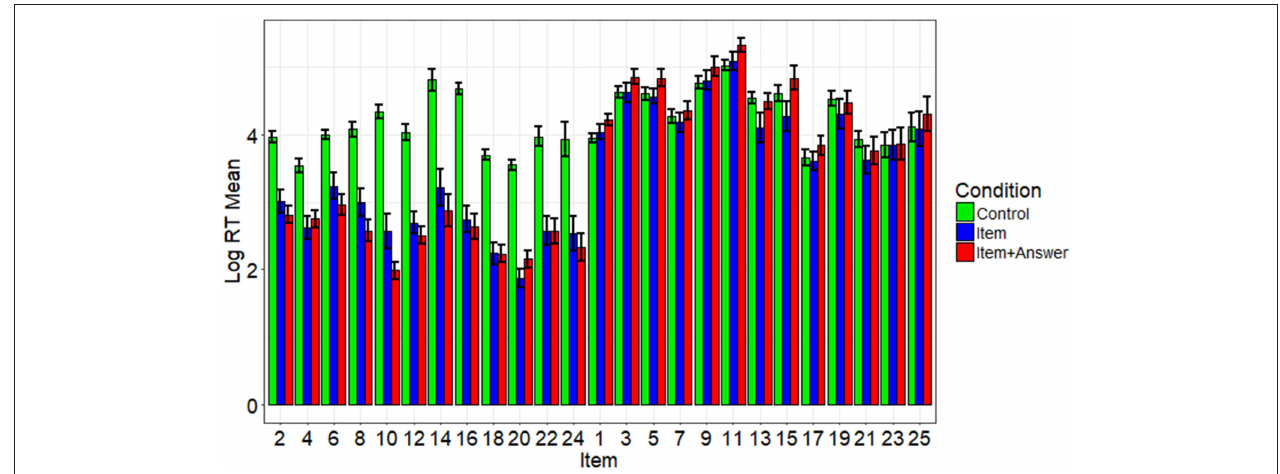
FIGURE 1 | Average log RTs by item and condition. This figure shows the average log RT by condition (see color) and item (see x-axis). Even-numbered items were disclosed and odd-numbered items were not. The error bars represent the standard errors.